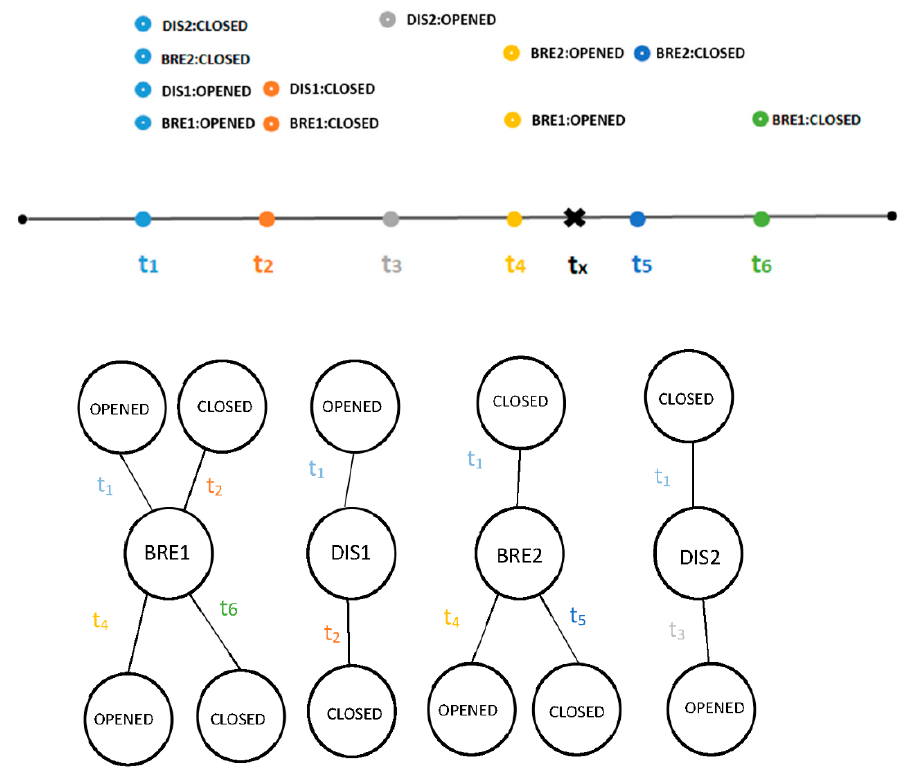
Figure 1. History of dynamic data in smart grids.